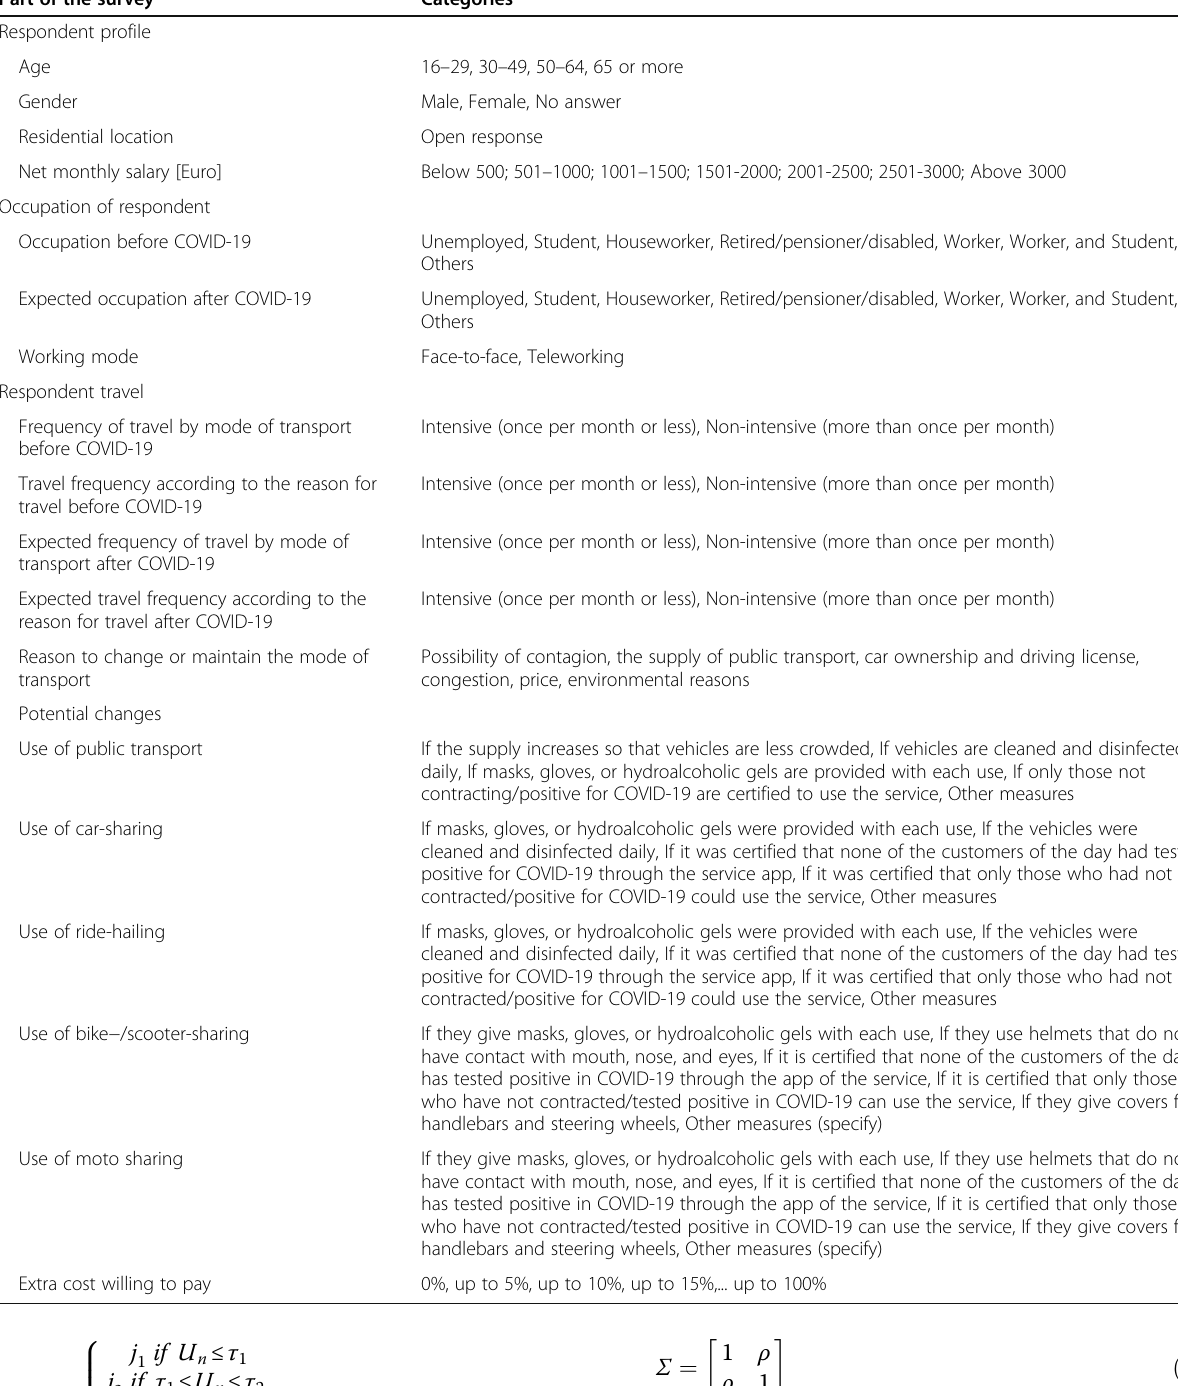
Table 1 Explanatory Variables collected in the research Part of the